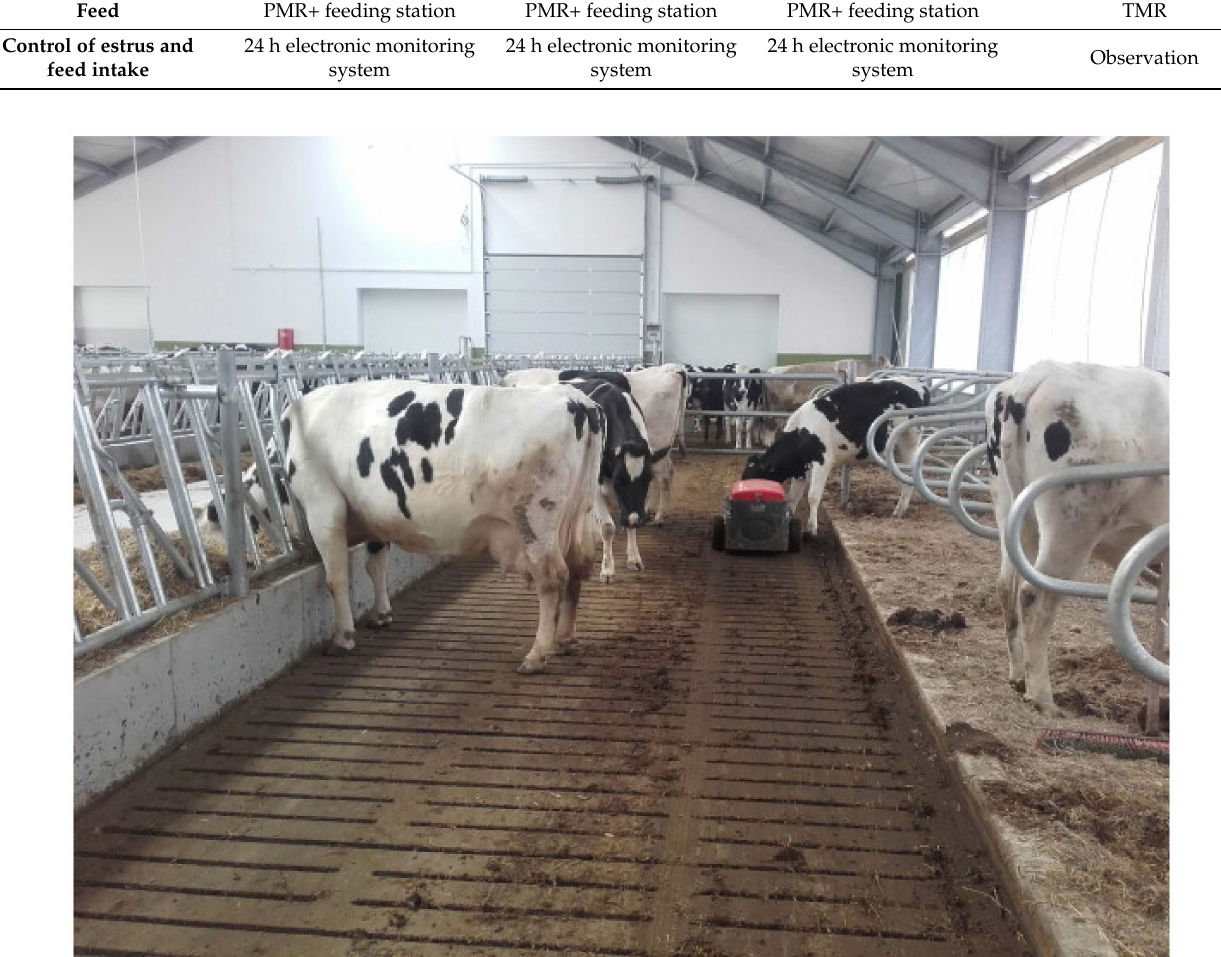
Figure 1. Free-stall barn with a slatted floor (A.